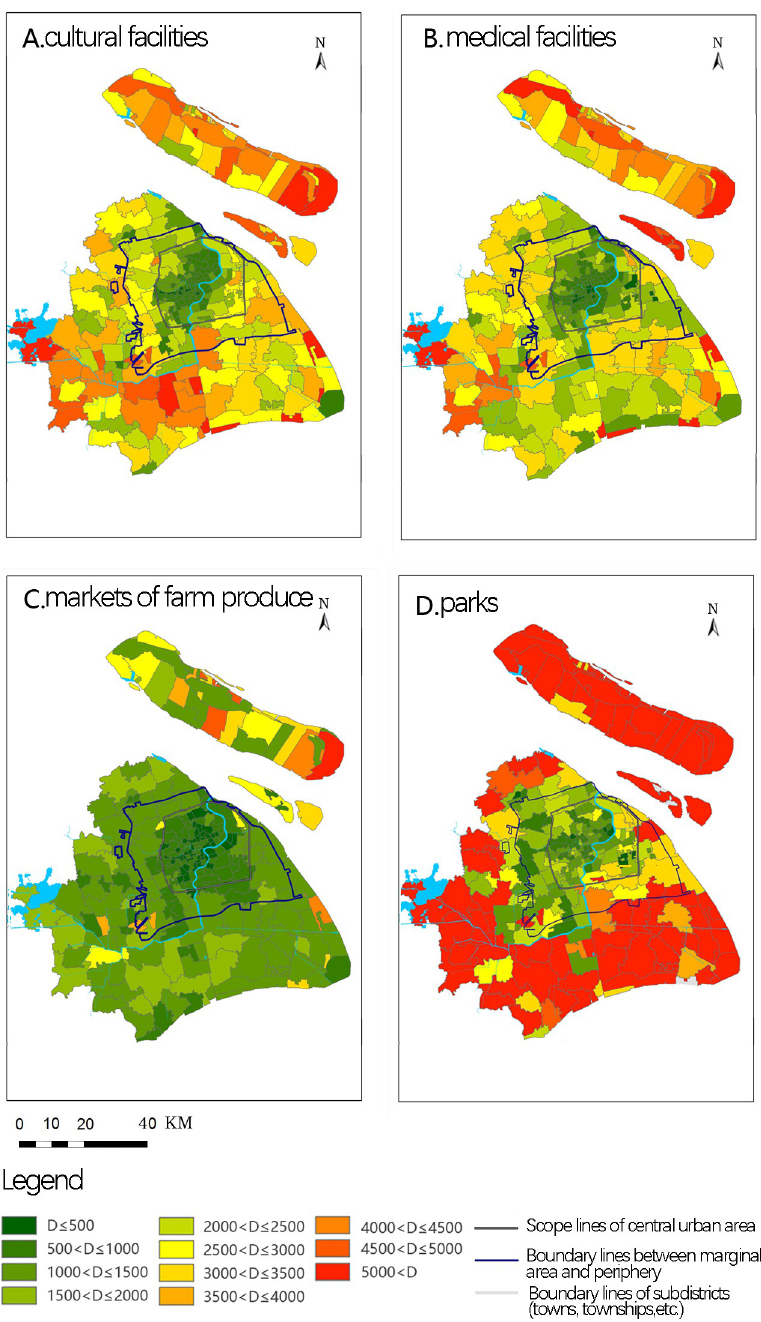
Fig 3. Distribution of accessibility levels of various facilities. Source: Created by the author based on the base map of Shanghai from the Open Street Map(OSM) geographic data platform(https://www.openstreetmap.org/).